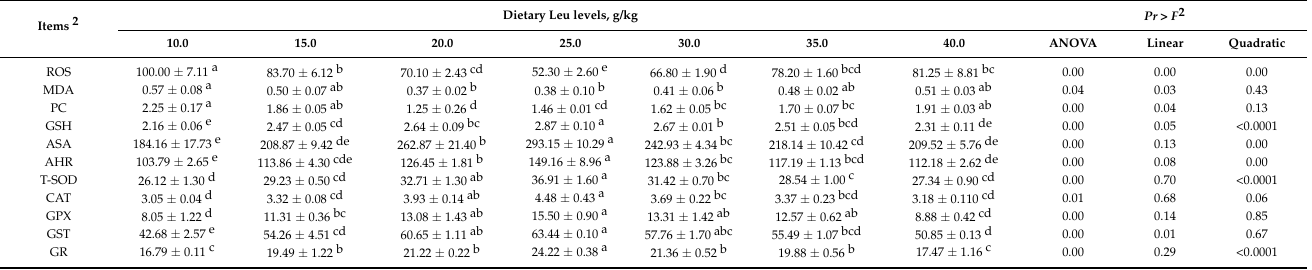
Table 2. Effects of dietary Leu on antioxidant-related parameters in the intestine of hybrid catfish fed experimental diets containing graded levels of Leu (g/kg) for 8 weeks 1